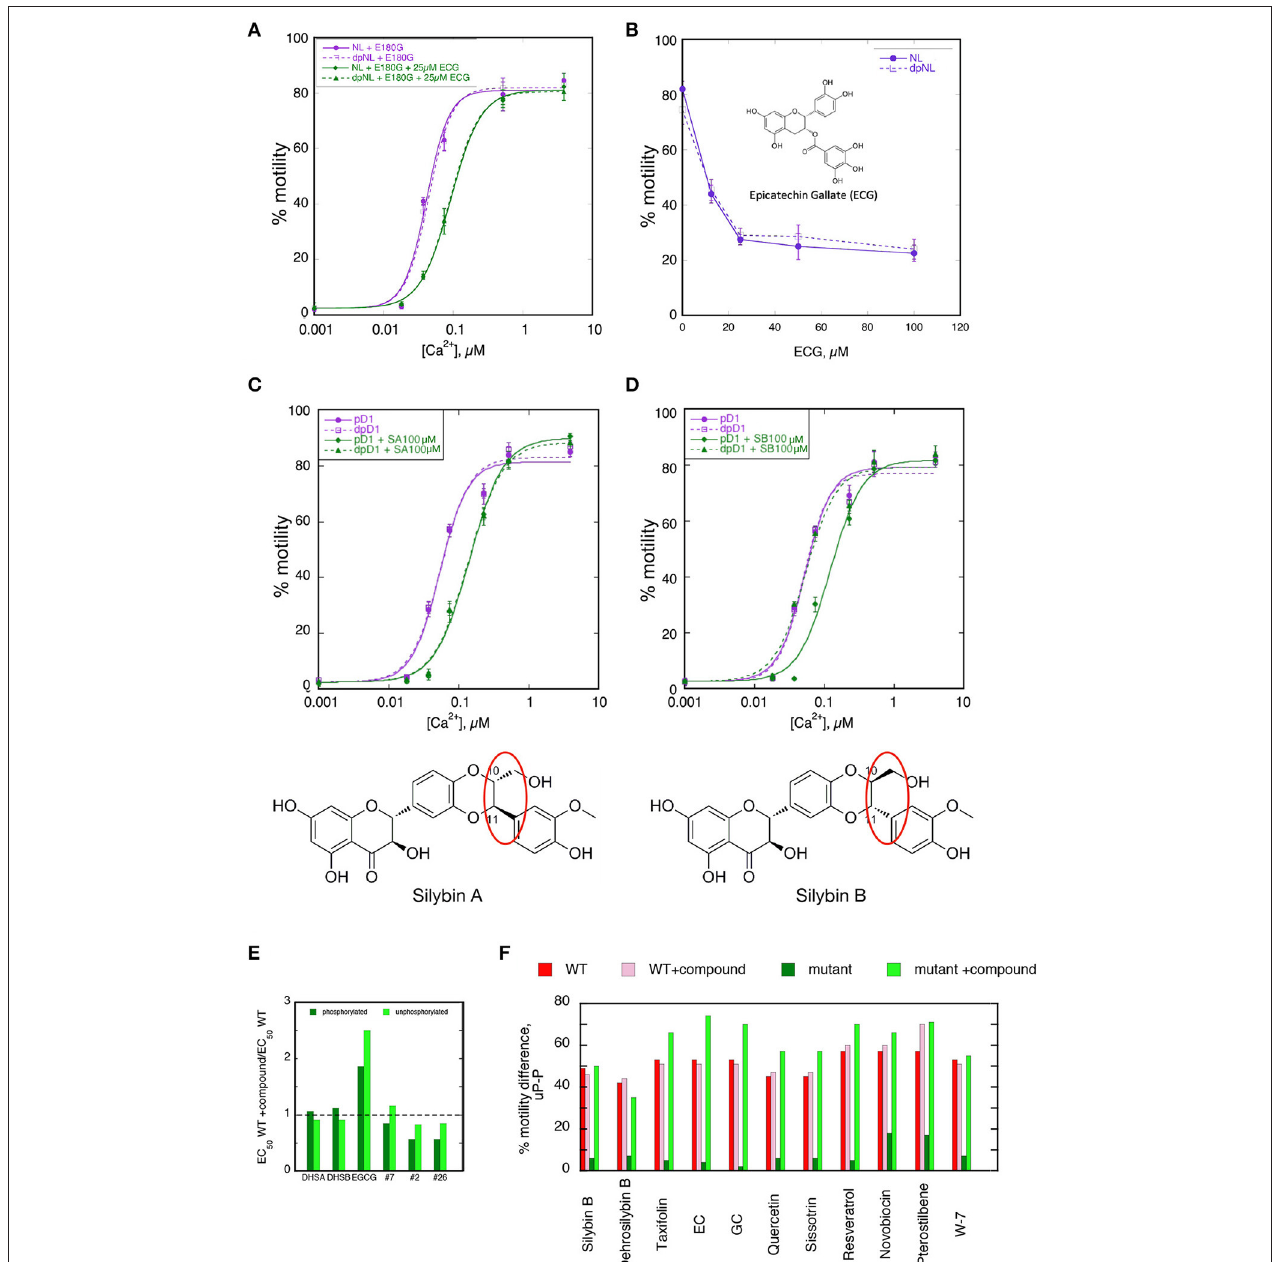
FIGURE 4 | Separation of desensitization and recoupling activities (A,B) Epicatechin gallate (ECG) is a desensitizer but not a recoupler. (A) Ca 2 + -activation curves for phosphorylated and unphosphorylated thin filaments containing E180G tropomyosin in the presence and absence of 25 µ M ECG. Solid lines, phosphorylated; dotted lines, unphosphorylated. Purple lines and points, E180G thin filaments; green lines and points, E180G thin filaments + ECG. (B) Dose-response curve for ECG activity measured at a constant Ca 2 + concentration of 0.037. (C,D) Silybin A is a pure desensitizer whilst Silybin B is a pure recoupler Ca 2 + activation curves are shown for phosphorylated and unphosphorylated thin filaments containing TnC G159D (DCM mutation) that are uncoupled. (C) In presence and absence of silybin A, (D) in presence and absence of Silybin B. Solid lines, phosphorylated; dotted lines, unphosphorylated. Purple lines and points, E180G thin filaments; green lines and points, E180G thin filaments + Silybin A or B. Structures of Silybin A and B are shown below the plots. (E,F) Compounds that recouple but are not Ca 2 + -desensitizers. (E) The effect of compounds on Ca 2 + -sensitivity of wild-type thin filaments. The ratio of EC 50 in the presence and absence of tested compounds is plotted for the phosphorylated (dark green) and unphosphorylated (light green) states. Only EGCG is a significant desensitizer. DHSA/B, Dehydrosilybin A/B. (F) The effect of 100 µ M drug treatment on the difference in fraction motile between phosphorylated and unphosphorylated states at 0.037 µ M Ca 2 + in the phosphorylated and unphosphorylated states (see Figures 2C,D ). Red bars, WT troponin; pink bars, WT troponin + compound. Dark green bars, E180G thin filaments, light green bars, E180G thin filaments + compound. Wild-type difference is unaffected by compound (not a desensitizer), whilst the value in E180G thin filaments is low indicating uncoupling, but restored by the compound indicating